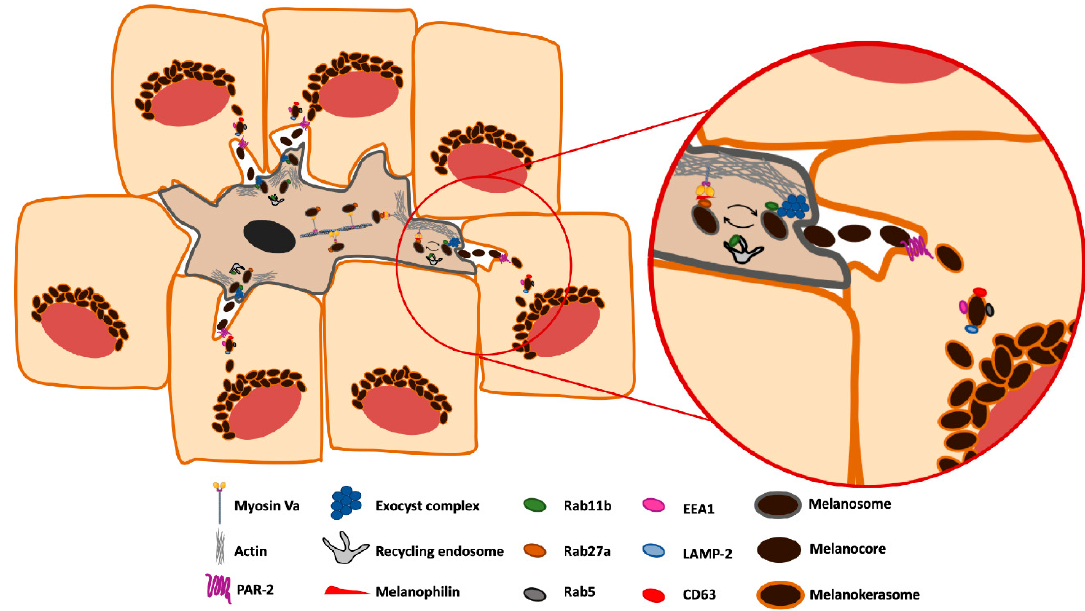
Figure 2. Schematic representation of melanin transfer between melanocytes and keratinocytes in the skin through exo/phagocytosis. After melanosome maturation and transport to the periphery of the melanocyte, Rab11b is recruited to melanosome membranes and the organelle interacts with the exocyst complex to allow melanocore secretion to the extracellular space. Following secretion, melanocores are phagocytosed by keratinocytes in a PAR-2 dependent manner. After internalization by keratinocytes, melanocores follow the endocytic pathway and colocalize with early and late endosomal markers, being stored in mildly acidic and degradative compartments, which we named melanokerasomes, that allow melanin to resist degradation.